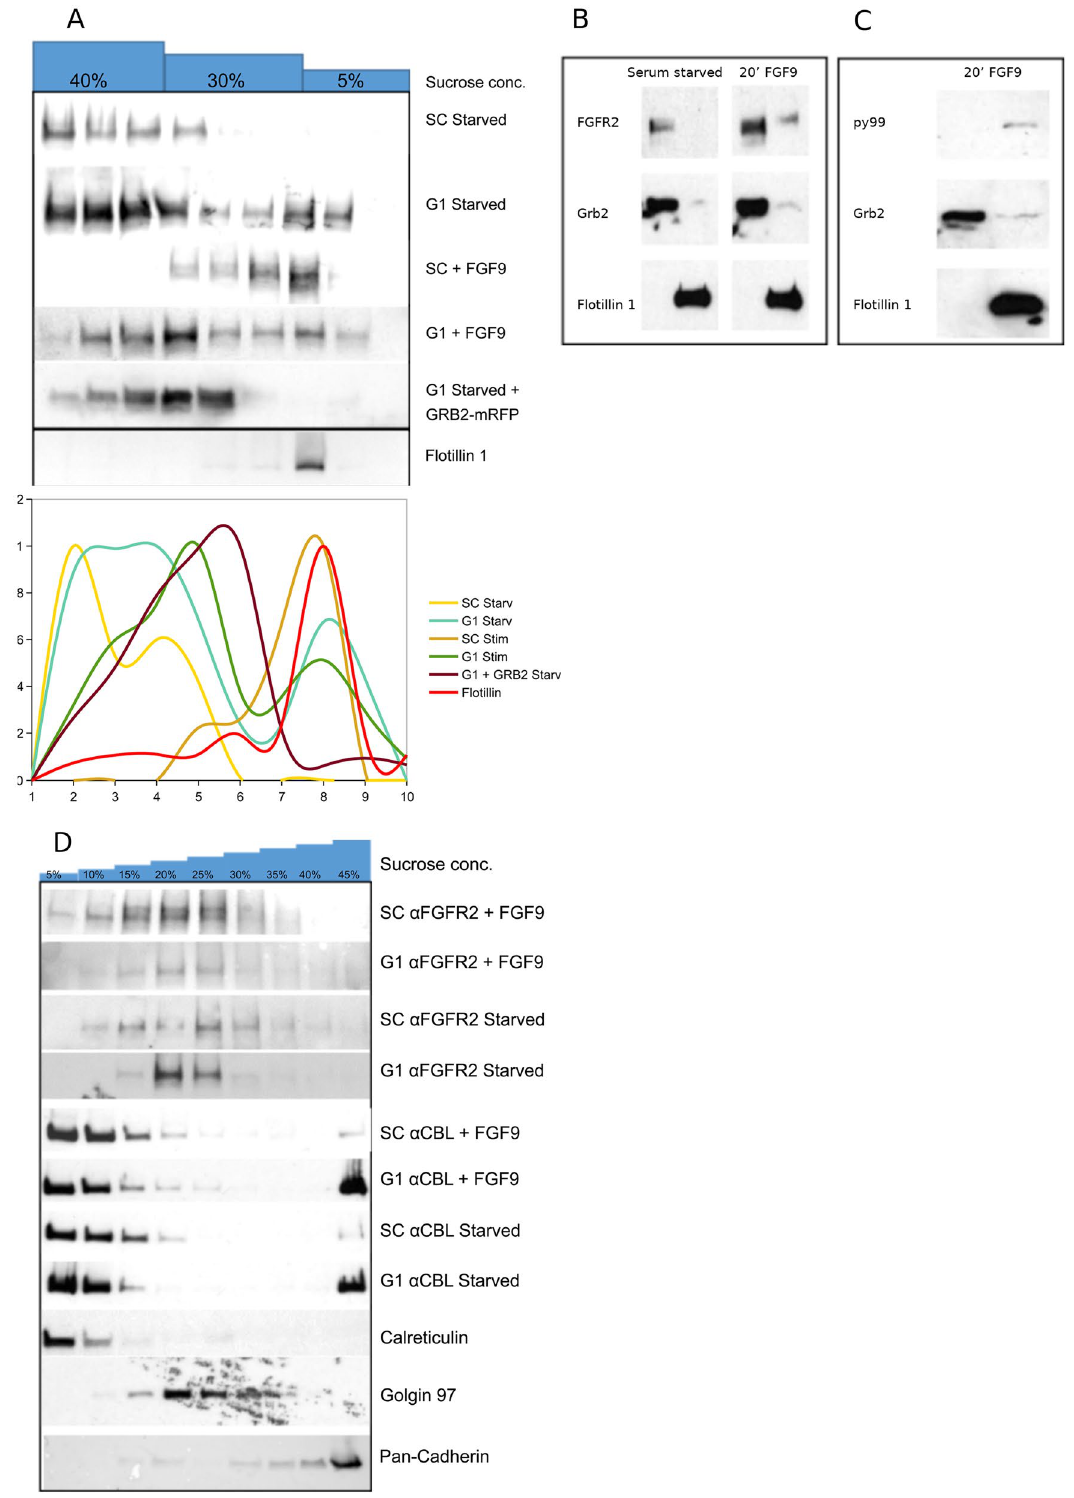
Figure 4. Biochemical DRM characterisation of FGFR2 distribution. ( A ) Sucrose gradient DRM separation showing the presence of FGFR2 in different sucrose concentrations. Flotillin-1 indicates DRM fraction. Separated panel shows distribution of Flotillin 1 across identical sucrose gradient. Line graph below shows normalized signal distribution along gradient. ( B – C ) Two step fractionation showing supernatant (first lane of individual blots) and pellet (second lane) fractions. Flotillin-1 marker DRM fraction (in pellet). ( D ) Sucrose gradient cell fractionation. An anti-CBL antibody was used to show fractional localisation of CBL in starved SC and G1 cells in the absence and presence of FGF9 stimulation. Calreticulin = ER marker, Golgin-97 = Golgi marker, pan-Cadherin = plasma membrane marker. Sucrose gradient blots are loaded on separate gels. The original blots are included in Supplementary Figure